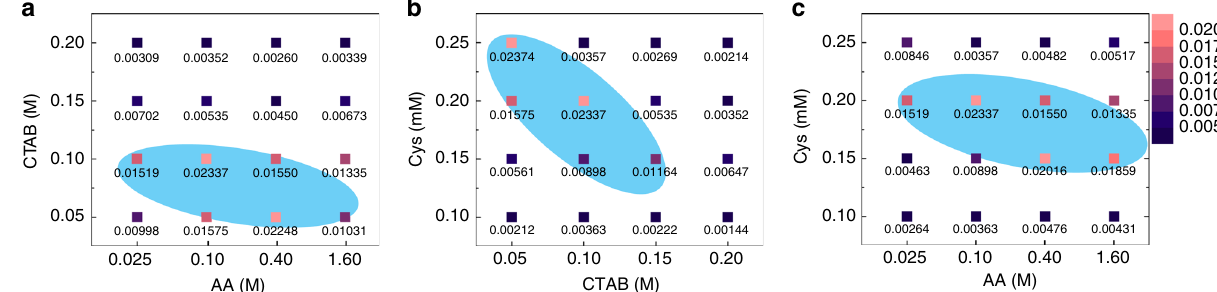
Fig. 5 Effect of the various concentration of cysteine, CTAB, and AA on g-factor. a – c The g-factors of the synthesized nanoparticles under various concentration combinations of CTAB and AA ( a ), Cys and CTAB ( b ), and Cys and AA ( c ) were plotted. While the two variables changed, the other factor remained the same: a Cys 0.2 mM, b AA 0.1 M, c CTAB 0.1 M were fi xed. The maximum g-factor (absolute value) of the synthesized nanoparticles under each condition is displayed with color and value. In the intensity scale on the left, pink represents the strongest and purple represents the weakest g-factor. High g-factor values above 0.01 are highlighted by blue